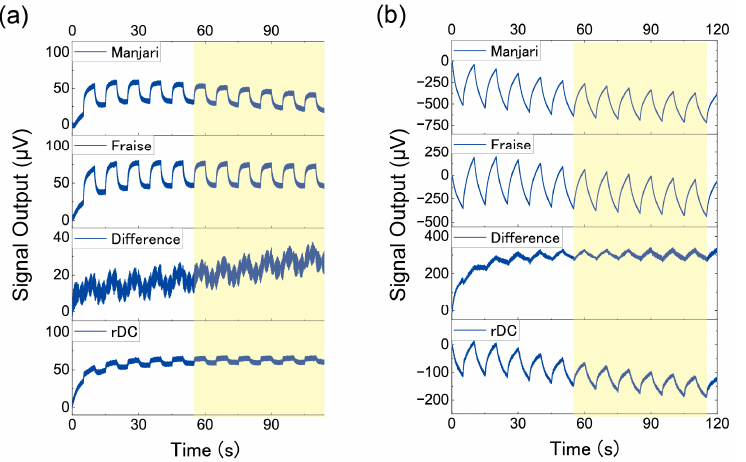
Figure 3. Whole sensing outputs of the measurements with ( a ) the PPPO-coated MSS and ( b ) the PS-coated MSS. Baselines are corrected at 0 s. Yellow-shaded areas are used for averaging. The noise levels were evaluated with the sensing outputs of the last 1 s of the repetition. As the sensing outputs can be considered linear in this period, the sensing outputs were fitted with straight lines. The noise levels were calculated from the residuals; the noise level was defined by the root mean square (RMS) of the residuals.